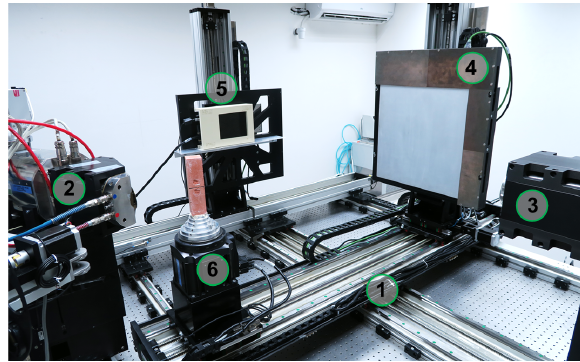
Figure 1. Illustration of fracture test in three-point bending (left), selected specimens after the fracture tests in three-point bending (top right), and specimen after test in compression (bottom right).